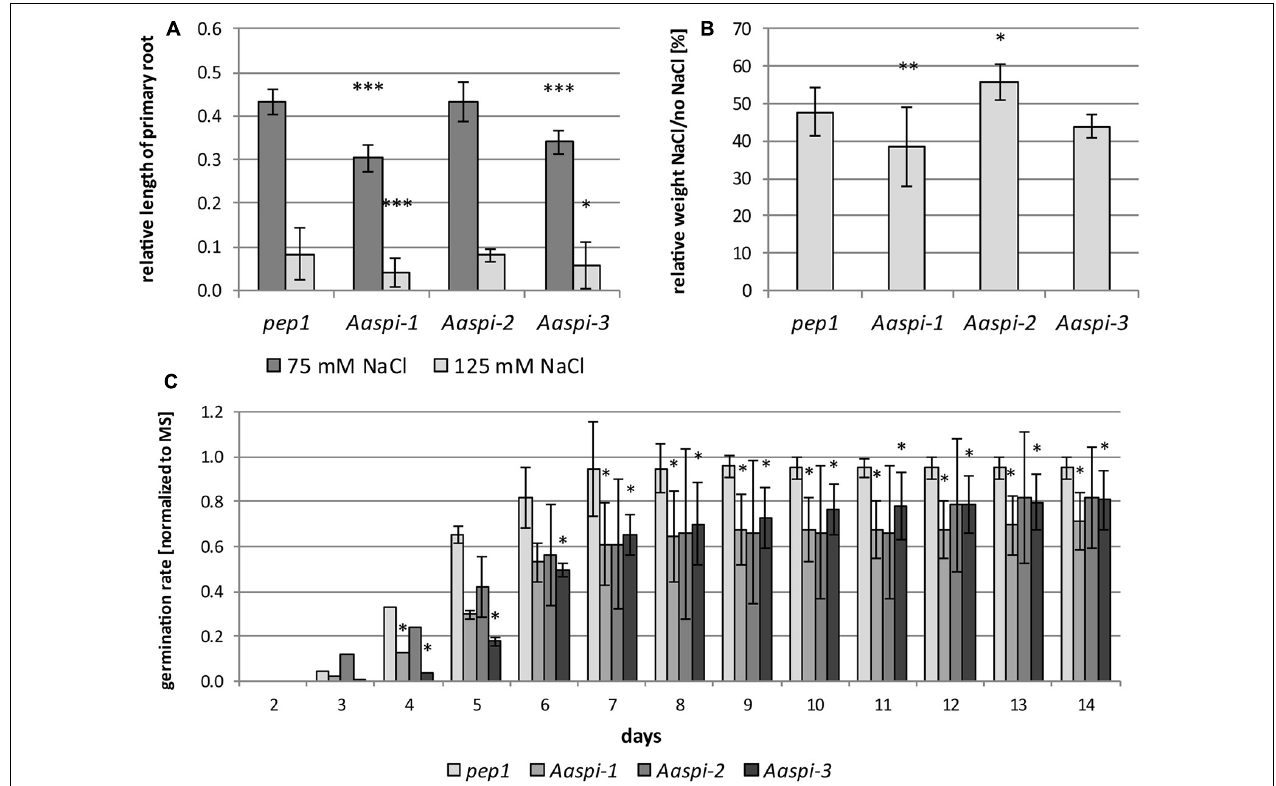
FIGURE 9 | Salt treatments in pep1 and Aaspi alleles. (A) Primary root growth of pep1 and Aaspi on different concentrations of NaCl after 4 days. Primary root growth under salt stress conditions was tested in three independent experiments. The assays were carried out on plates containing 0 mM NaCl, 75 mM NaCl and 125 mM NaCl, respectively. Roots were measured after 4 days of growth. Significance of the data was tested using an ANOVA with p < 0.001 (***), p < 0.01 (**), and p < 0.05 (*). Total N per line per condition 93–128. (B) Seedling growth of Arabis alpina lines on soil under salt stress. Plants were watered every 3–4 days with water for the first 20 days, subsequently plants were watered with either water or water with 125 mM NaCl ( N = 27–31 per line and condition). The weight of the seedlings was determined after 30 days. Significance of the data was tested using ANOVA with p < 0.001 (***), p < 0.01 (**), and p < 0.05 (*). (C) Germination of pep1 and spi mutants under salt stress. Germination of pep1 and the three Aaspi mutants was analyzed on MS plates and MS plates supplemented with 125 mM NaCl in three independent sets ( N > 115 per line and condition). The relative number of seeds germinated on salt media was normalized against the values from media containing no salt and combined between the sets. Error bars depict standard deviations. Significance was tested using Mann-Whitney-U at a level of * p <